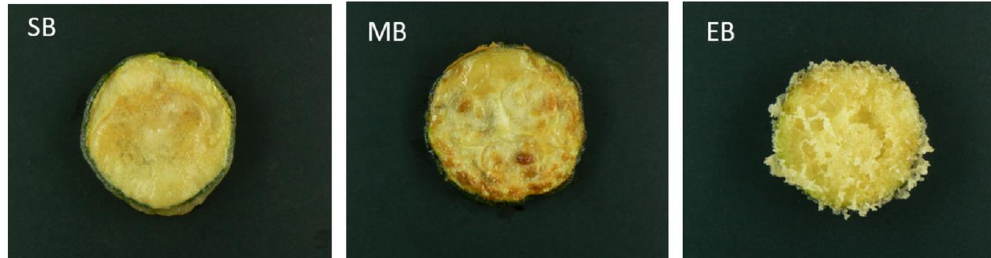
Figure 1. External appearance of different tempura batter zucchini samples after frying during 260 s at 170 °C. SB: standard batter; MB: maltodextrin batter; EB: ethanol batter. The L*, a*, b* color parameters of the fried samples processed with the three different batter formulations are shown in Table 3. As expected, longer frying times resulted in lower L* values, indicating that the samples were darker. Moreover, the addition of maltodextrin to the batter formulation significantly influenced the lightness parameter, as MB samples had a darker surface than SB and EB samples. This could be explained by the greater presence of chain ends with reducing frequency of non-enzymatic browning reactions [25].